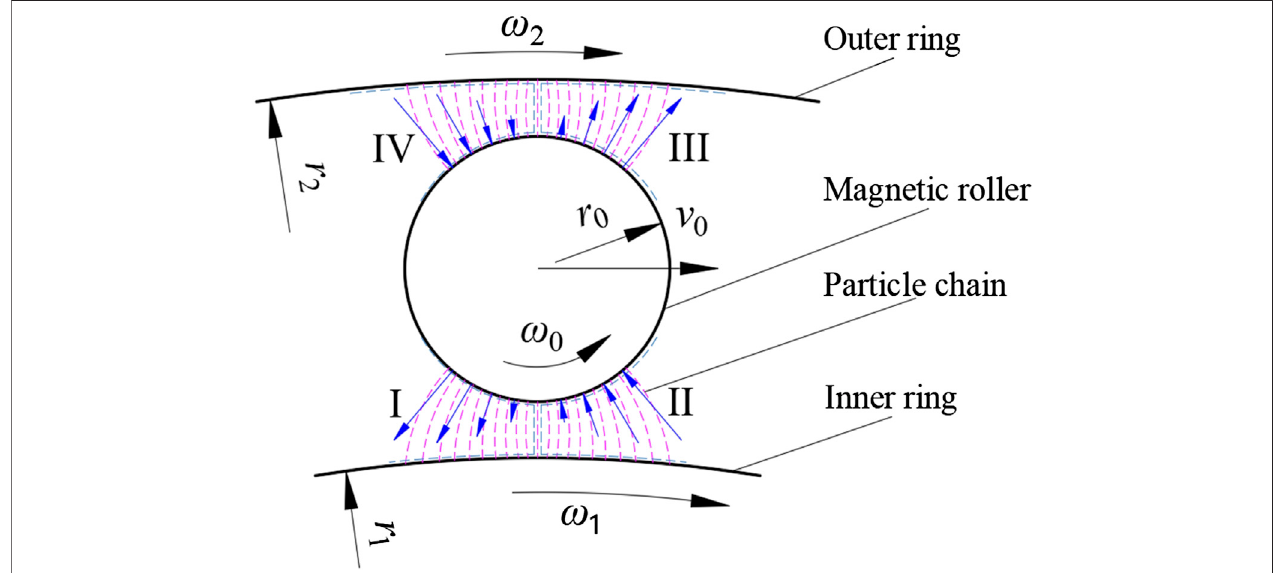
FIGURE 2 | Mechanism analysis of the planetary